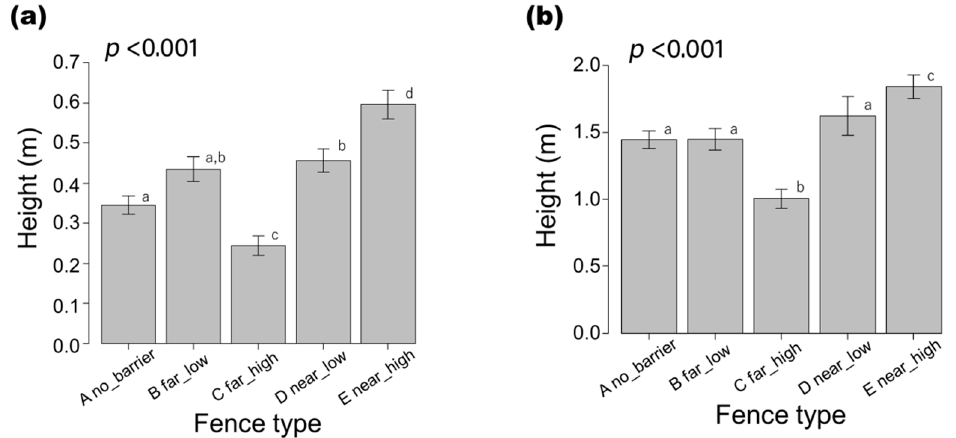
Figure 3. Difference in flying height by ( a ) fence type and ( b ) distance class. Letters above the error bars represent the results of Bonferroni’s post-hoc pairwise comparison test. Error bar heights are means ± standard error.